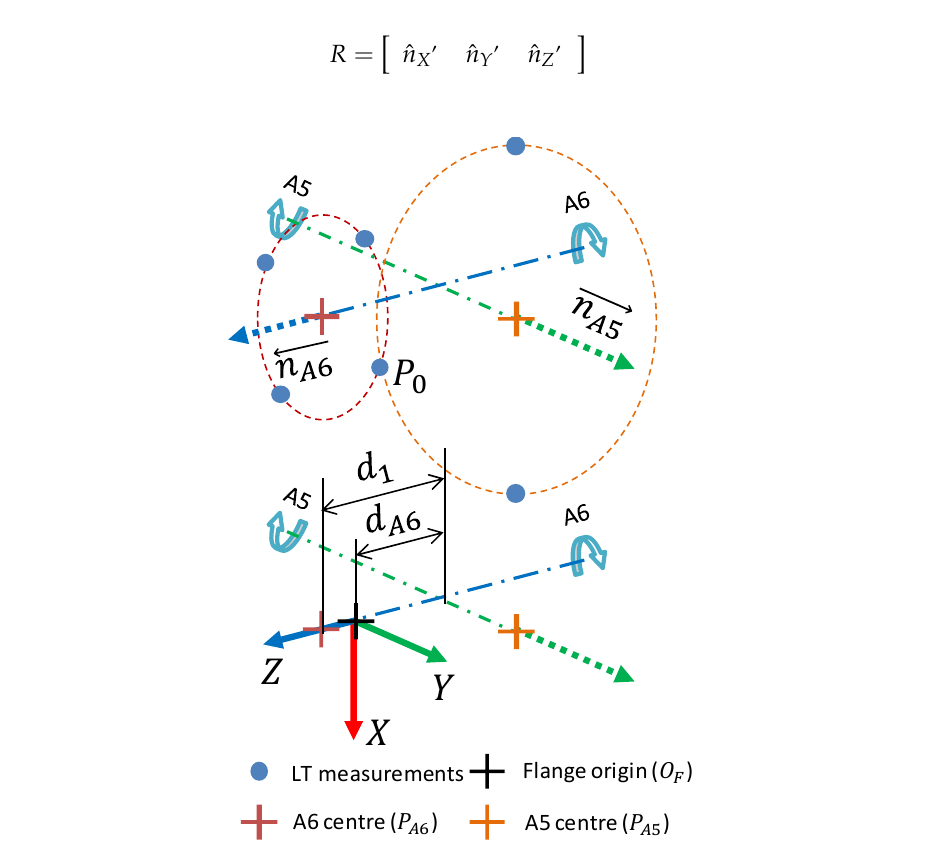
Figure 5. Reconstruction of the robot flange reference frame.